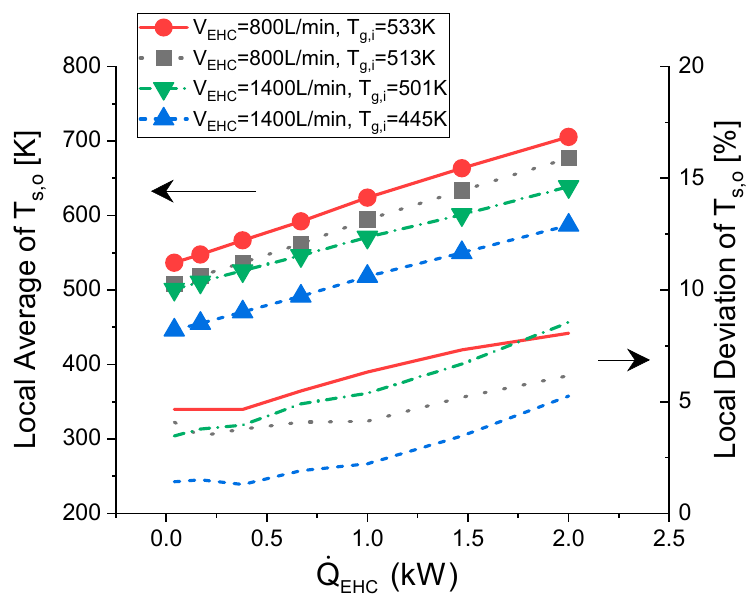
Figure 6. Local average and deviation results of T s , o measured using IR camera.